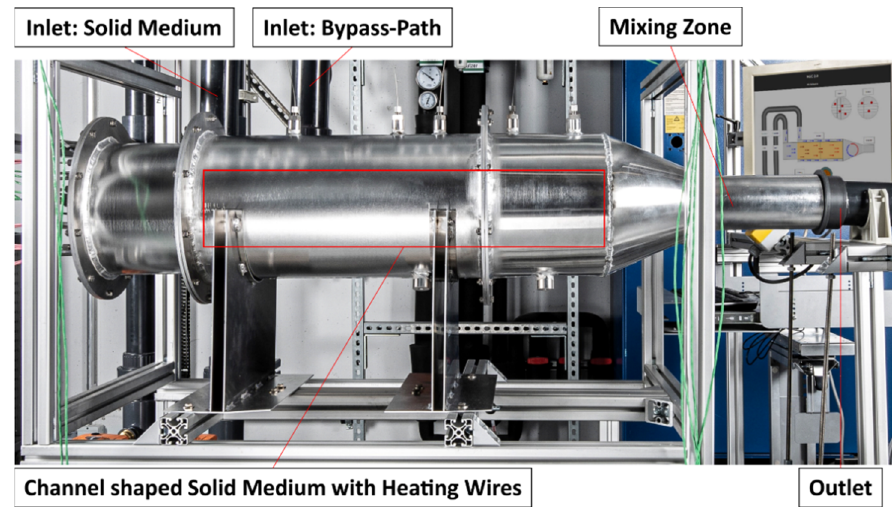
Figure 3. Test Rig—electrically heated thermal storage system based on solid materials.